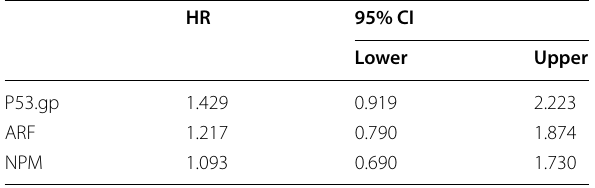
Table 6 Univariate Hazard ratio analysis of gene mutations and DFS